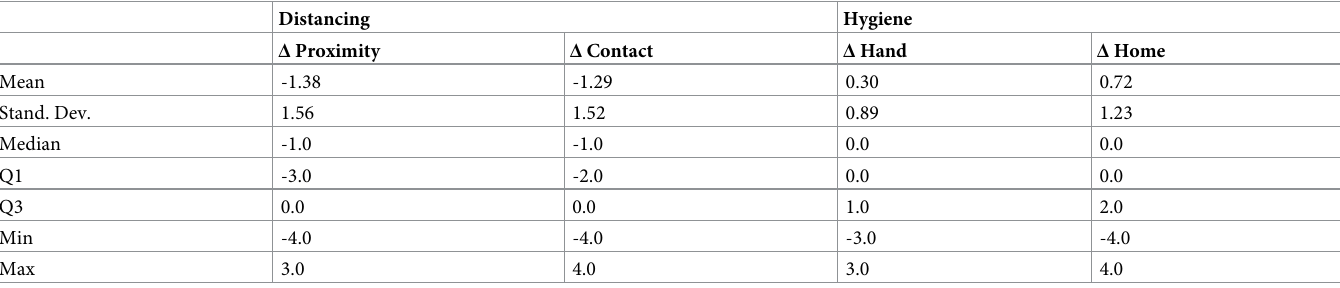
Table 2. Descriptive statistics for measures of change in mitigation